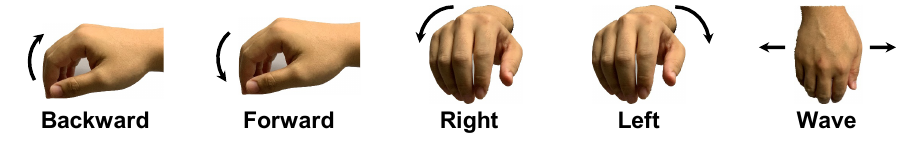
Figure 4. Illustration of the target